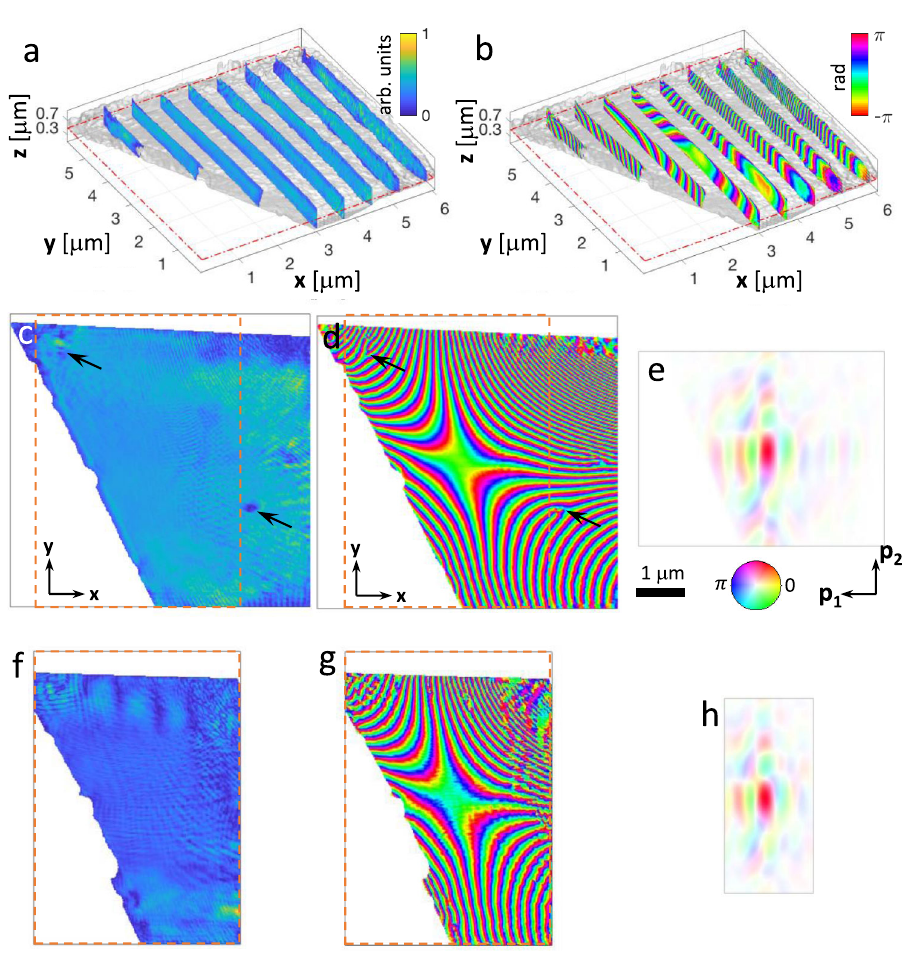
Fig. 3 Extended fi eld of view retrieved image. a 3D density and ( b ) phase plots, retrieved with the proposed BP approach in the ( x , y , z ) laboratory frame. The grey volume represents an iso-surface based on the recovered object density, while the slices show the internal structure of density and phase, respectively. The fi eld of view extends over 0.6 × 6 × 6 μ m 3 . c , d Cross sections of the crystal density and phase, respectively, shown over the plane indicated by red dashed rectangles at z = 4.7 μ m in ( a ) and ( b ), and ( e ) the associated retrieved probe. f , g 3D density and phase reconstructions, respectively, obtained from the same dataset, using the former BP approach. Note the strong reduction of the fi eld of view (evidenced by the dashed rectangle) and the degradation of the image quality. A comparison of the total possible fi eld of view is shown in supplementary Fig. 3d, including regions of the possible fi eld of view that are non-scattering due to the fi nite extent of the considered crystal. h Probe cross-section, plotted in the ( p 1 , p 2 ) plane, used for this second reconstruction, limited along p 1 according to the conjugation relations applied to the experimental parameters. As the probe is kept fi xed during this process, the probe pro fi le is extracted from a separate and dedicated probe reconstruction (Methods). The colour scale for the density, phase and probe (hue rendering) are indicated on the plots ( a ), ( b ) and ( e ),